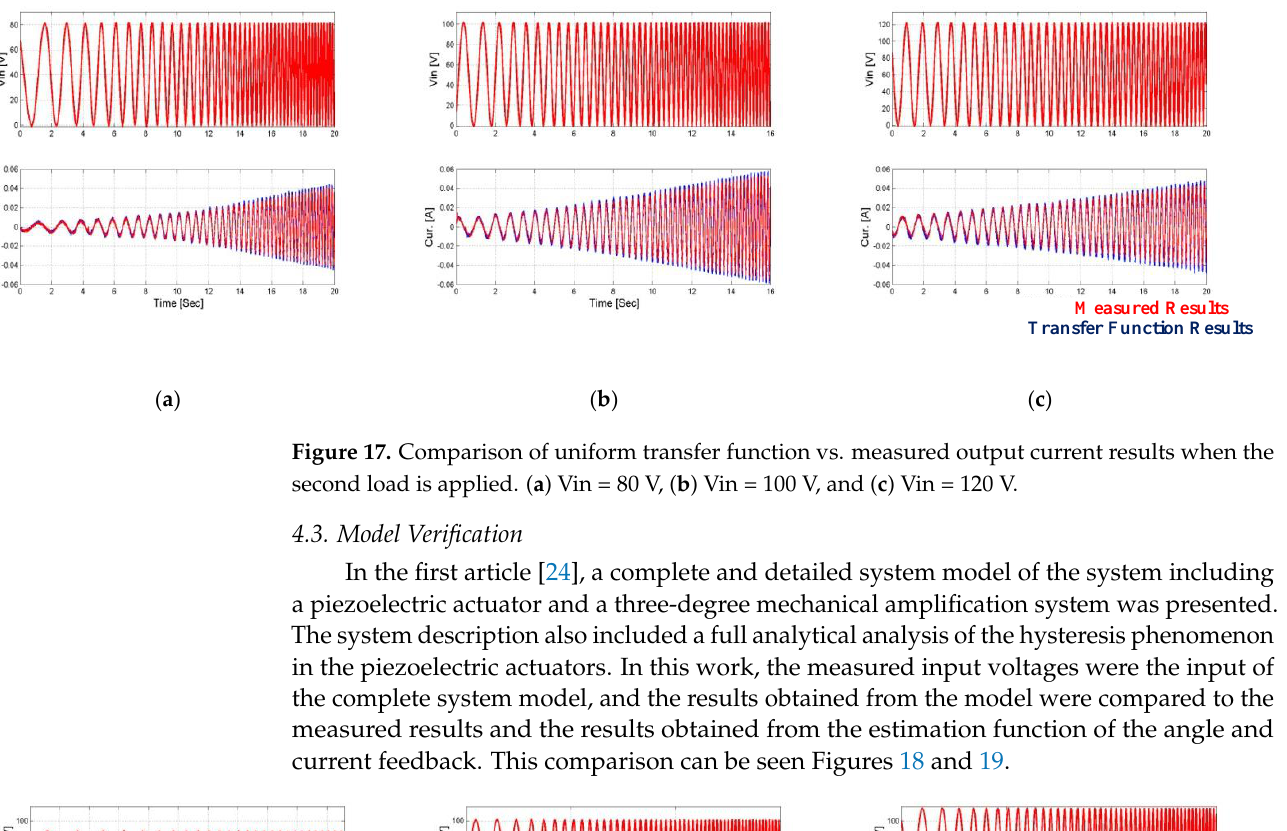
Figure 16. Comparison of uniform transfer function vs. measured output current results when the first load is applied. ( a ) Vin = 80 V, ( b ) Vin = 100 V, and ( c ) Vin = 120 V.